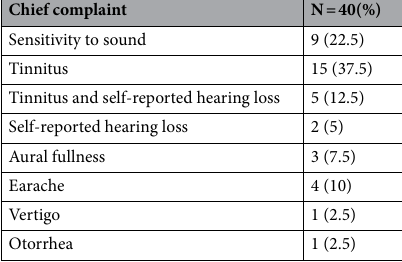
Table 2. Complaints of patients with hyperacusis at visit